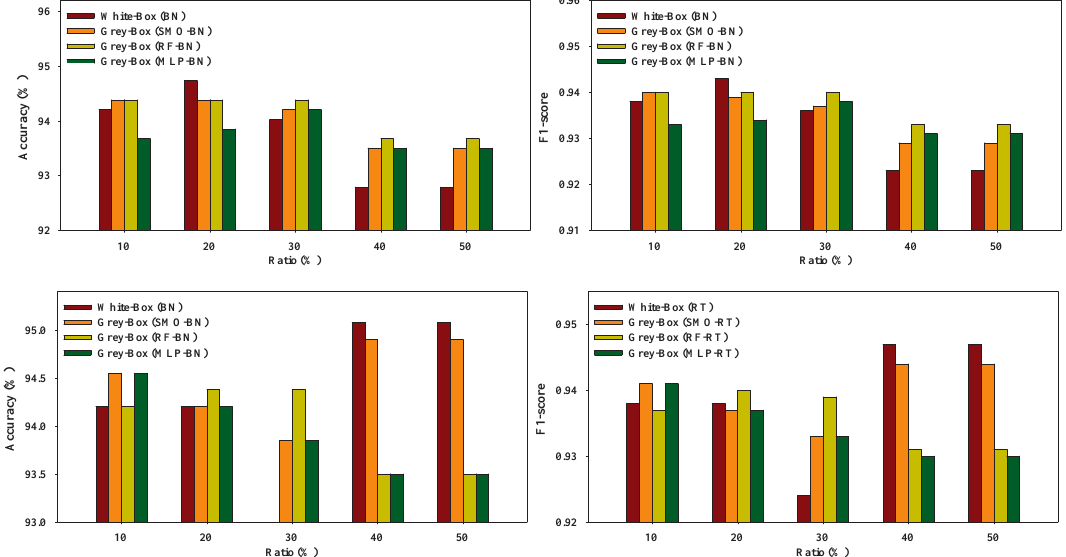
Figure 8. Box-plot with performance evaluation of Grey-Box and White-Box models for Winsconsin